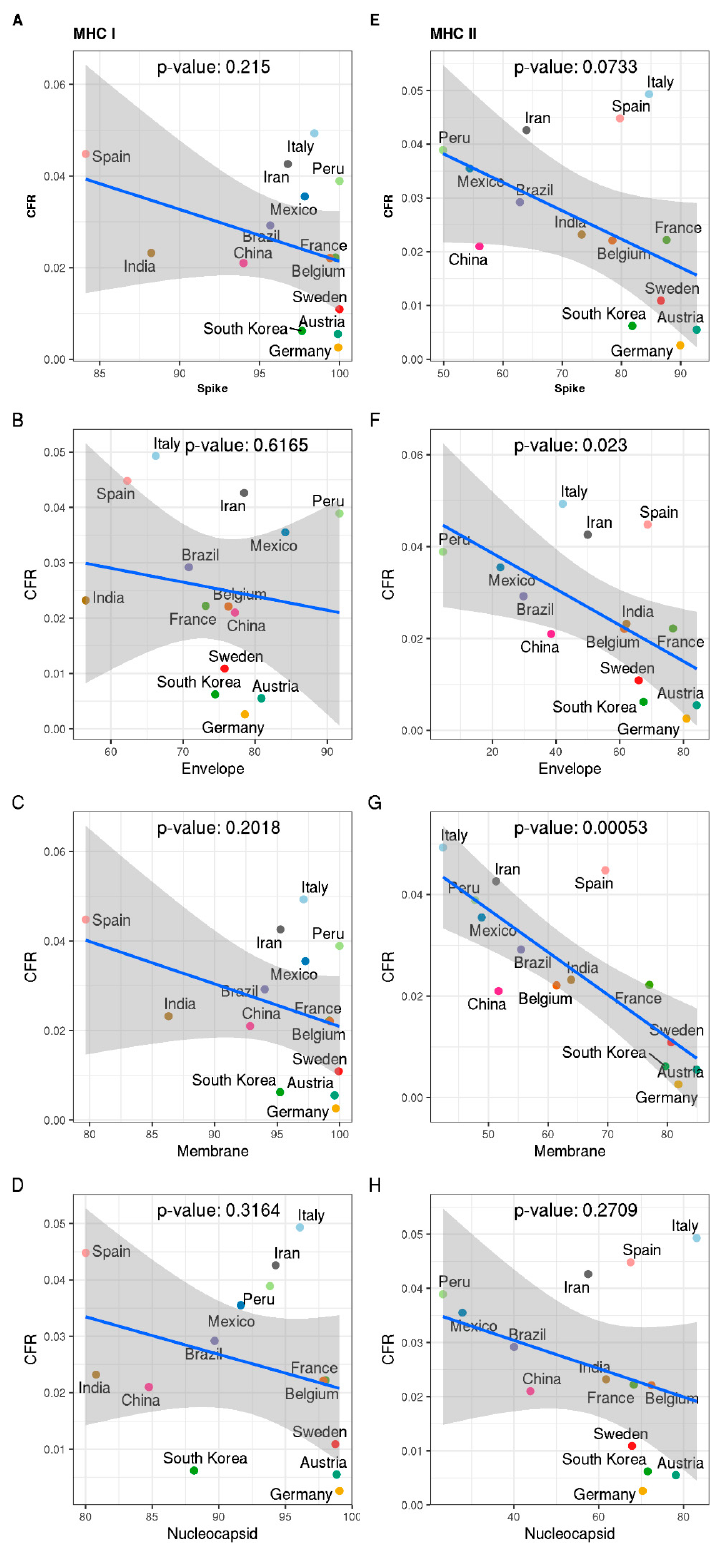
Figure 4. Correlation of predicted MHC-presentation and case fatality rate (CFR) in different